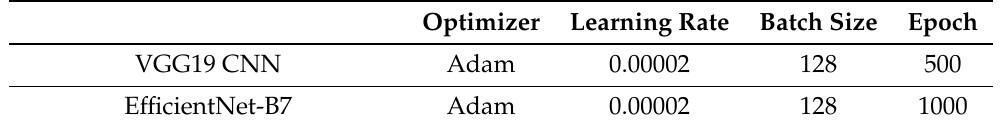
Figure 6. VGG19-based CNN model for VA classification. Table 6. Learning parameters for VGG19 and EfficientNet-B7.